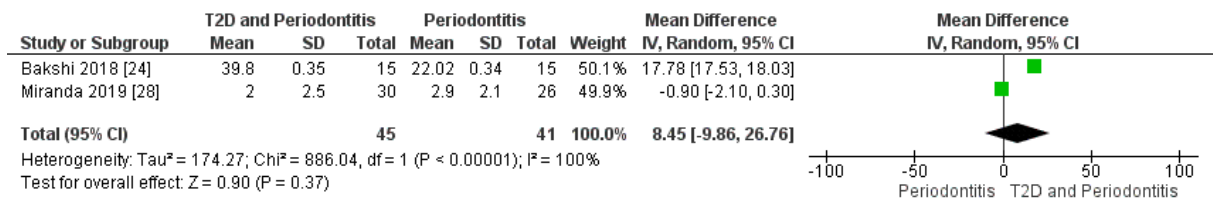
11 Braz. Oral Res.